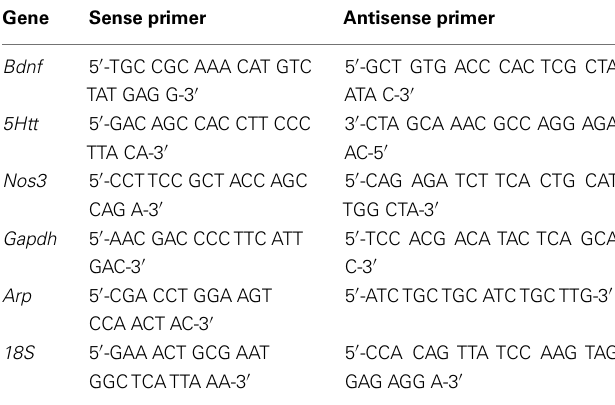
Table 1 | Primer sequences for quantitative PCR analysis.